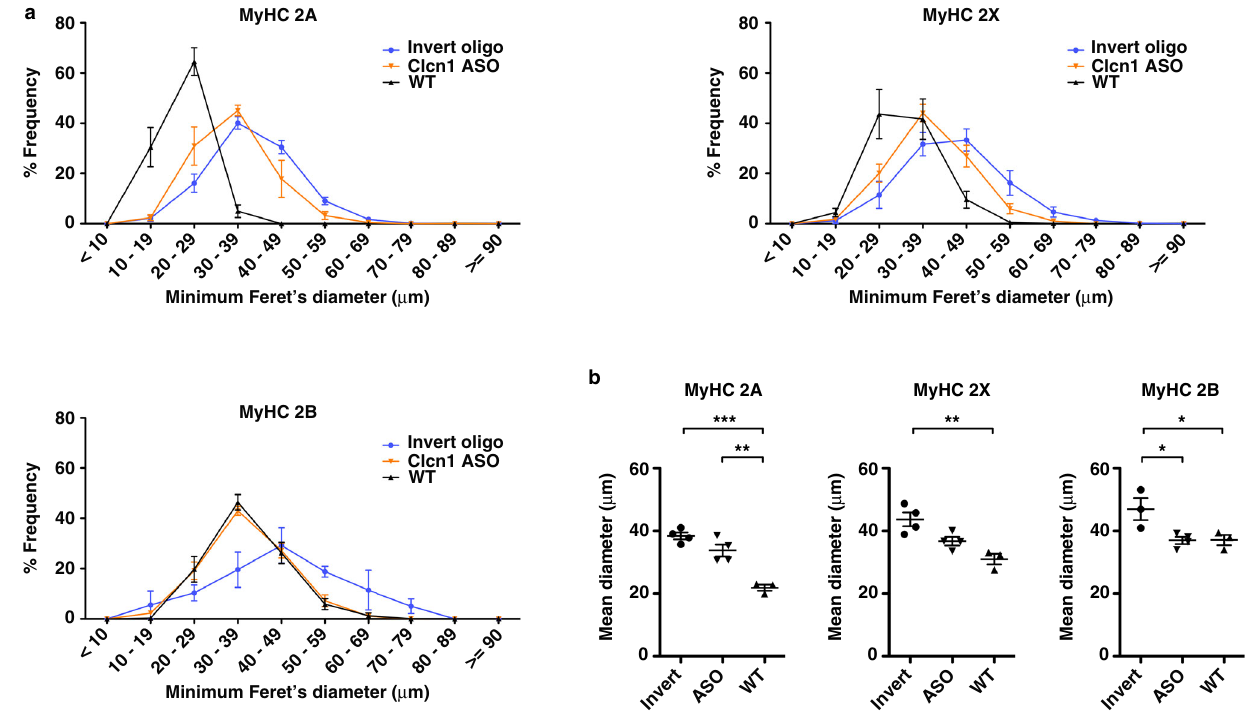
Fig. 7 | Fiber diameter in treated muscles. a We measured minimal Feret ’ s dia- meter, de fi ned as the minimum distance between parallel tangents 37 , of tibialis anterior (TA) muscle fi bers in LR41; Mbnl1 − / − treated with Clcn1 ASO or invert oligo ( N =4 each). Untreated wild-type (WT; N =3) served as controls. Diameter is